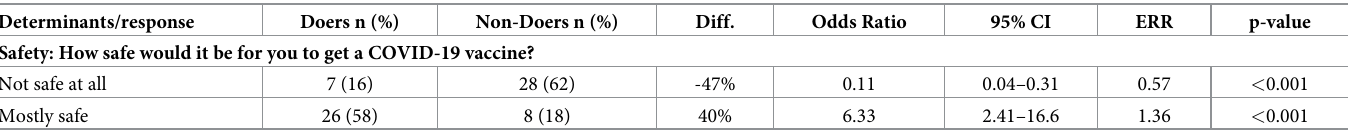
Table 3. Perceived safety and risk.